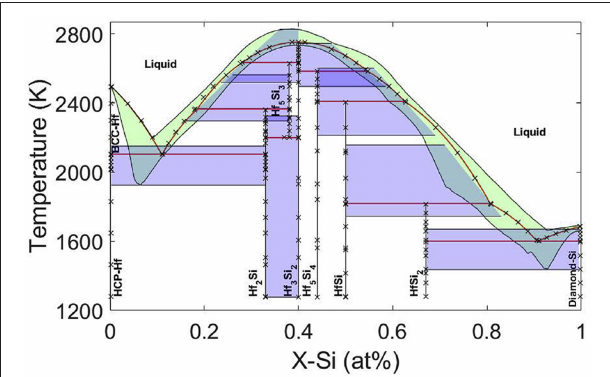
FIGURE 12 | Posterior modes and 95% Bayesian credible intervals (BCIs) at different compositions/regions in Hf-Si phase diagram obtained after BMA. Reproduced with permission from Honarmandi et al.